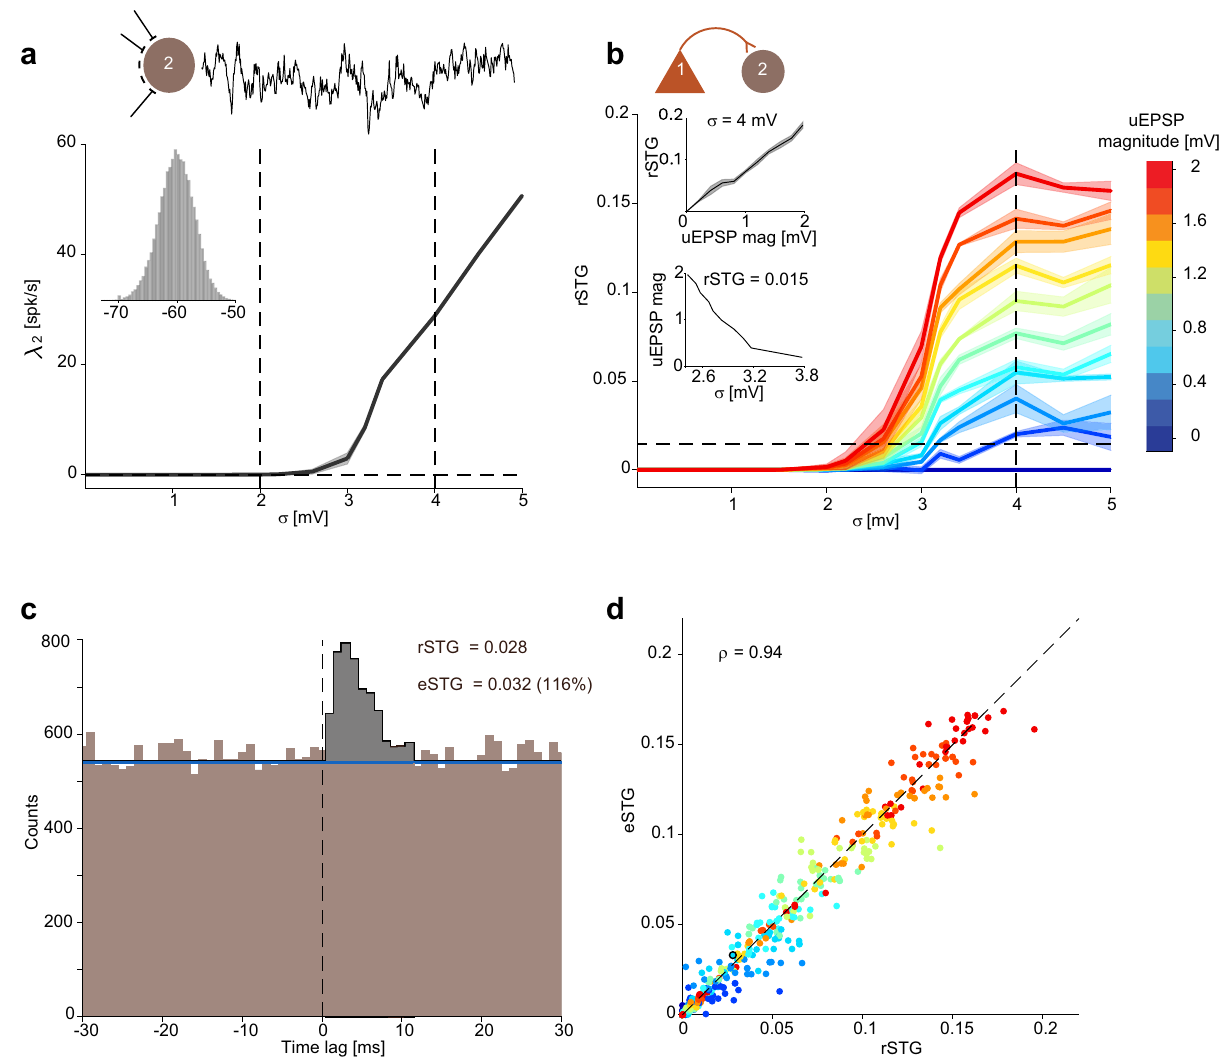
Fig. 1 Spike transmission between two neurons can be estimated from spike times. a Increased membrane potential variability increases spontaneous spiking. A leaky integrate and fi re (LIF) model neuron was simulated with different levels of membrane potential variability, quanti fi ed by the noise SD, σ ( n = 6 repetitions for each of n = 11 σ values, from 0 to 5 mV with 0.5 mV increments; each 180 min). The fi ring rate ( λ 2 ) of the simulated neuron is shown for each σ value; here and in ( b ), error bands indicate SEM. The trace next to the cartoon shows 300 ms of simulated membrane potential, and the histograms show the distribution of membrane potentials ( σ = 3 mV). b Even small-magnitude EPSPs induce observable spike transmission gain in the presence of noise. The simulated LIF neuron (2) was driven via an excitatory synapse by a presynaptic neuron (1) with Poisson spiking ( λ 1 = 5 spk/s) modi fi ed by refractoriness. Synaptic conductance was modi fi ed to yield n = 11 different unitary EPSP (uEPSP) magnitudes (from 0 to 2 mV with 0.2 mV increments), and the real spike transmission gain (rSTG) was computed for every σ and uEPSP combination ( n = 121). Both uEPSP magnitude and membrane potential variability control spike transmission. c A cross-correlation histogram (CCH; bins size: 1 ms) was computed from a pair of simulated spike trains as in ( b ); σ = 3.4 mV, uEPSP magnitude = 0.6 mV. For deriving an estimated STG (eSTG) from the CCH, the level of baseline joint counts (blue line) was fi rst estimated using the “ tails ” predictor, averaging CCH values at time lags | τ | ≥ 11 ms. The spike transmission curve (STC; black line) was estimated as the above-baseline curve with a peak in the temporal region of interest (ROI; de fi ned here as 0 < τ ≤ 5 ms; gray bins), with zeros in all other bins. The eSTG is the area under the estimated STC. d Spike transmission gain estimated from the CCH is an accurate estimate of the real STG. For every simulation run ( n = 6 repetitions for each of 121 σ and uEPSP combinations), rSTGs and eSTGs were computed. Different colors correspond to different uEPSP magnitudes as in ( b ), and the black circle corresponds to the example in ( c ). Spearman ’ s correlation coef fi cient between eSTG and rSTG is ρ = 0.94 ( n = 726 random samples, p < 0.001, permutation